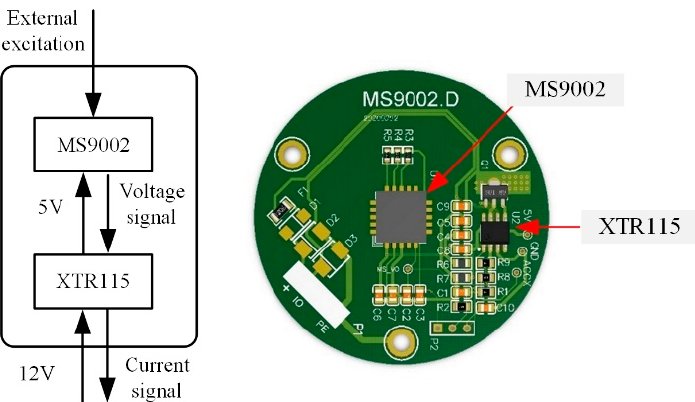
Figure 3. The Printed Circuit Board (PCB) of the acceleration sensing